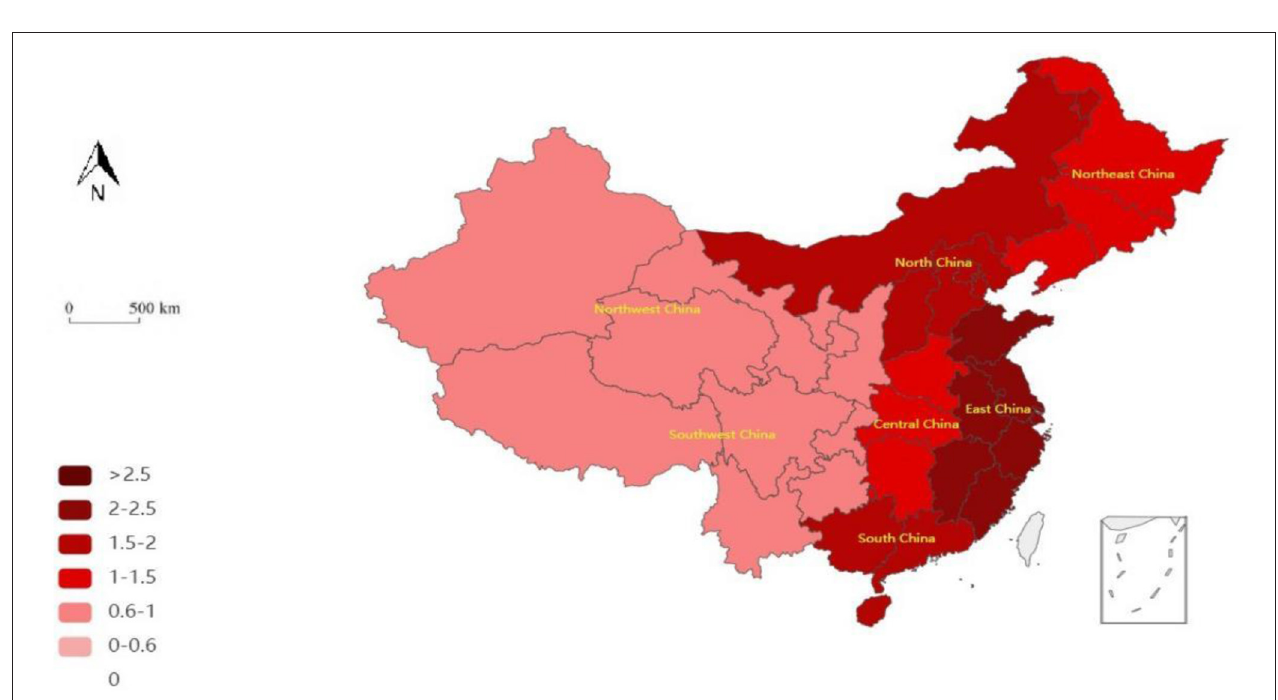
FIGURE 4 | Adjusted geographical pattern of the efficiency of medical PPP projects during China’s 13th 5-Year Plan period.